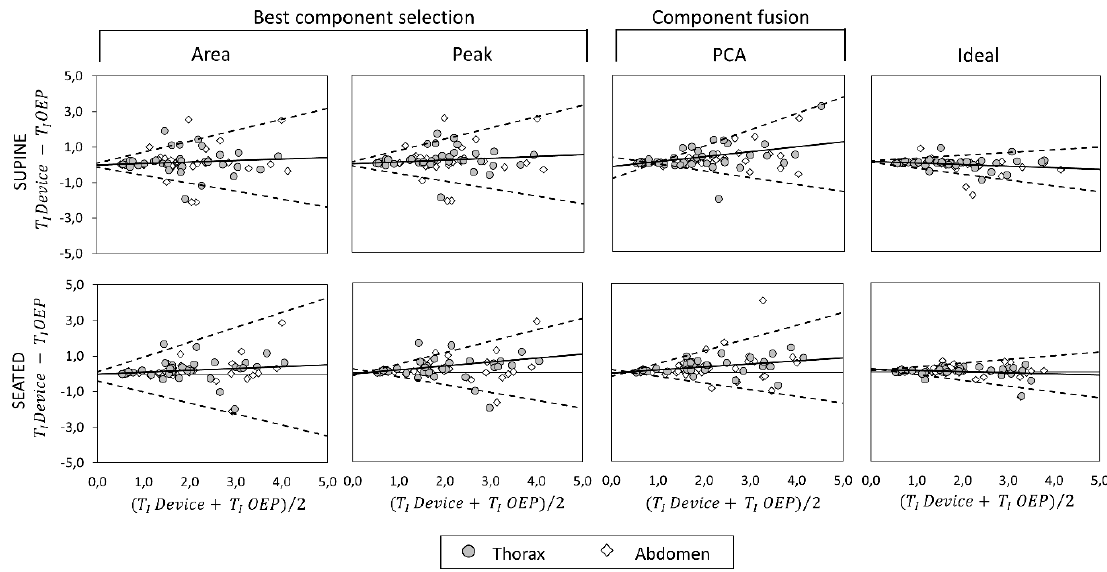
Figure 9. Agreement analysis between OEP and the IMU-based device for inspiratory time (T I , [s]) measurements, in supine (top panels) and seated (bottom panels) position. In each Bland–Altman plot the differences between measurements of T I obtained by using the IMU-based device and by using OEP are plotted against the mean of the two measurements. For homoscedastic data, the mean of the differences (bias: —) and limits of agreement (- - -) from mean − 1.96 s to mean + 1.96 s are represented by lines parallel to the X axis. For heteroscedastic data, the proportional bias (—) is represented by the OLS line of best fit for differences on mean values; V-shaped upper and lower 95% confidence limits (- - -) are calculated according to Bland [44].